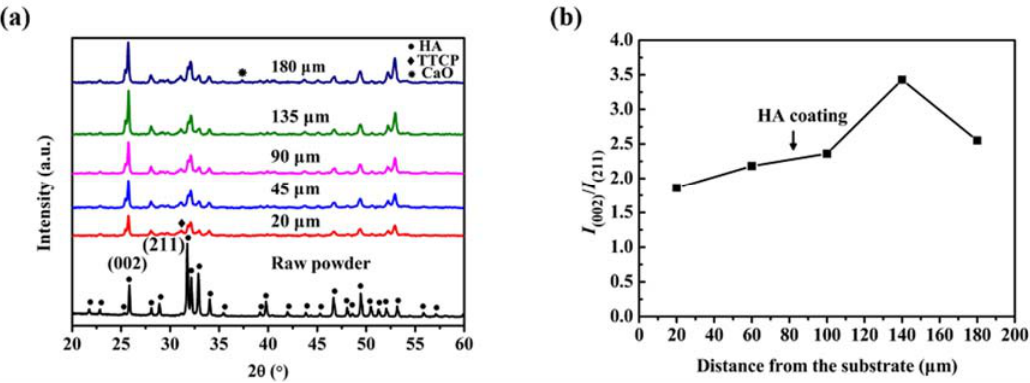
Figure 1. ( a ) XRD patterns of raw powder and XRD patterns at different distances from the coating/substrate interface in the as ‐ sprayed HA coating, and ( b ) (002) orientation intensity variations coating/substrate interface in the as-sprayed HA coating, and ( b ) (002) orientation intensity variations along the coating depth. along the coating